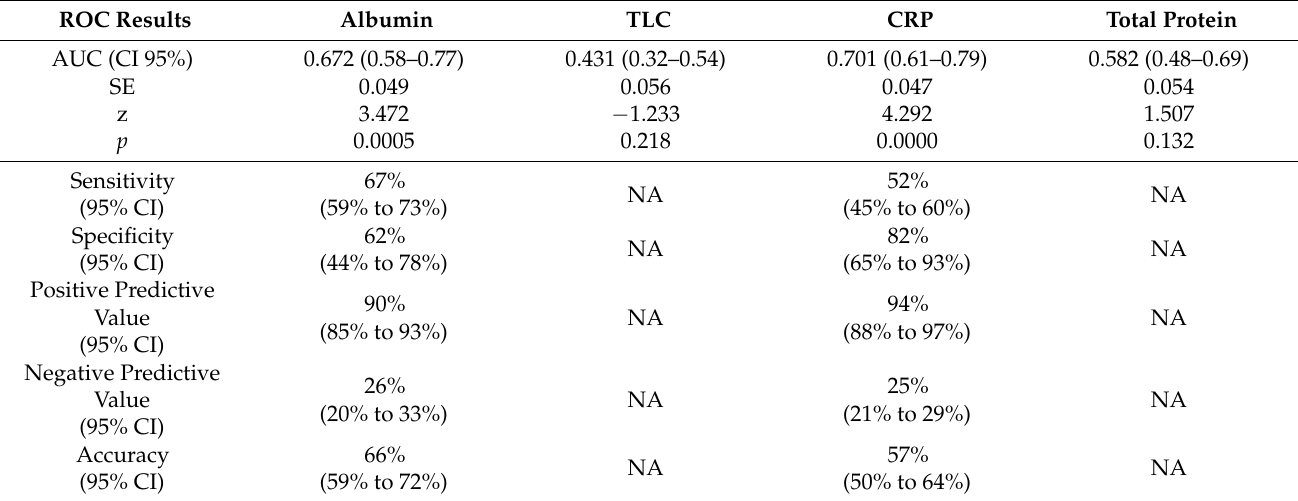
Table 6. ROC analysis results of the biochemical data investigated in the study as predictors of GLIM-based malnutrition.